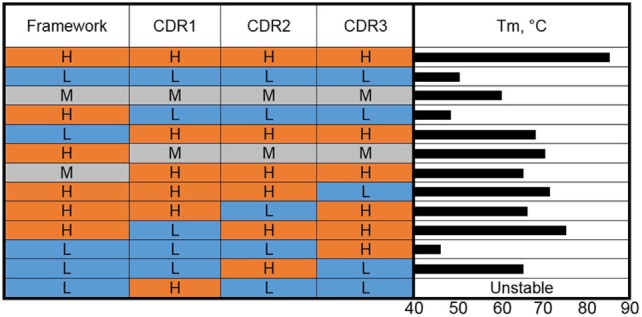
Complementarity-determining region (CDR) grafting and thermal stability. VHHs of high (H), medium (M), and low (L) thermal stability (color coded as red, gray, and blue) were used as the basis for construction of genetic hybrids. The framework regions (as a unit) and the individual CDRs were mixed in various combinations. The Tms of the resulting hybrids are shown as a bar graph on the right side.